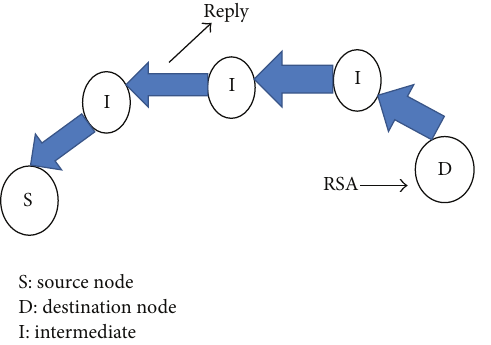
Figure 3: Destination node 𝐷 sends a reply to source.